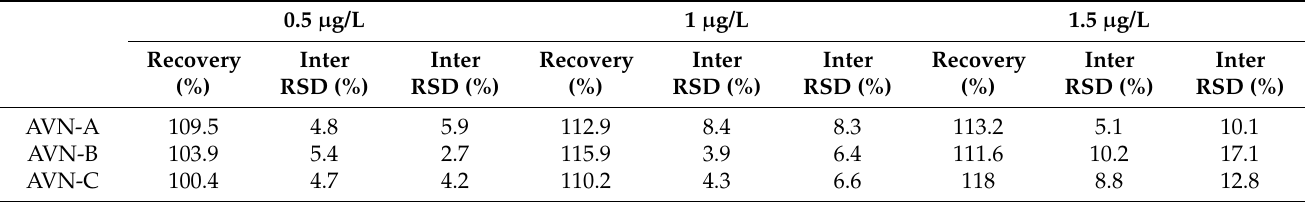
Table 4. Recovery and precision of anthracene amide that was added to the sprouted oats. 0.5 µ